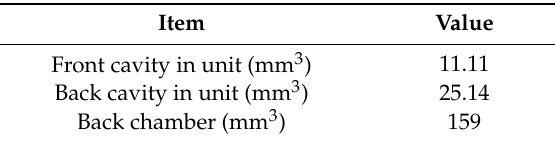
Table 4. Parameters of cavities.